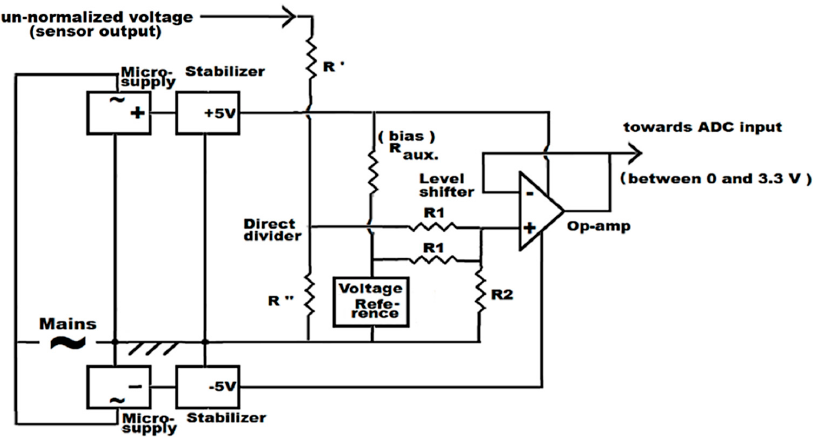
Figure E1. Analog signal-conditioning mini-adapter with adjustable resistor-divider scaling and precision shifting based on a low-dropout voltage reference.